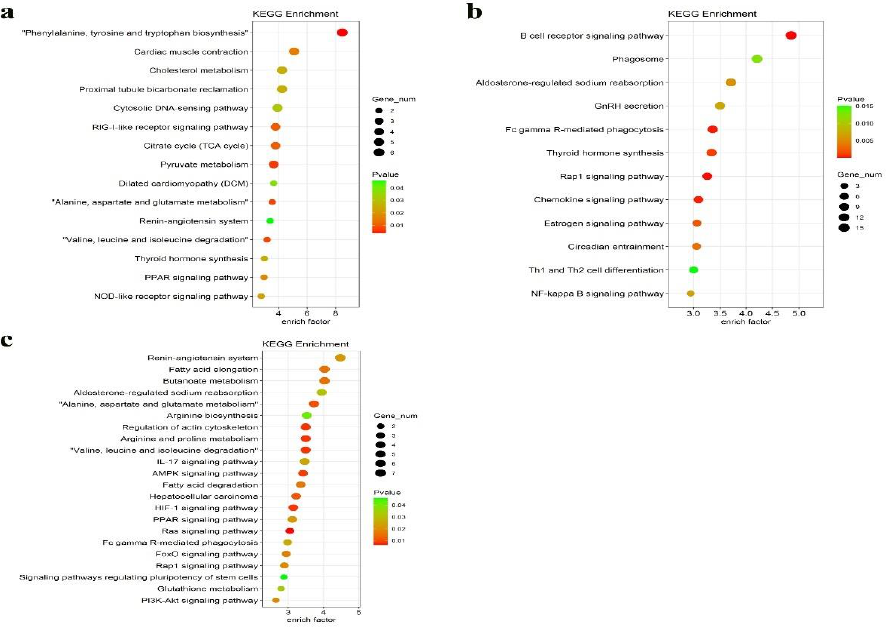
Figure 7. Significant KEGG terms of DEGs. ( a ) LD60 vs. LD120. ( b ) LD60 vs. LD240. ( c ) LD120 vs. LD240. Note: The Y-axis represents the name of the pathway, and the X-axis represents the enrich factor. The larger the enrich factor, the greater the degree of enrichment. The size of the dots indicates the number of genes in this pathway. The color of the dots corresponds to different p -value ranges.